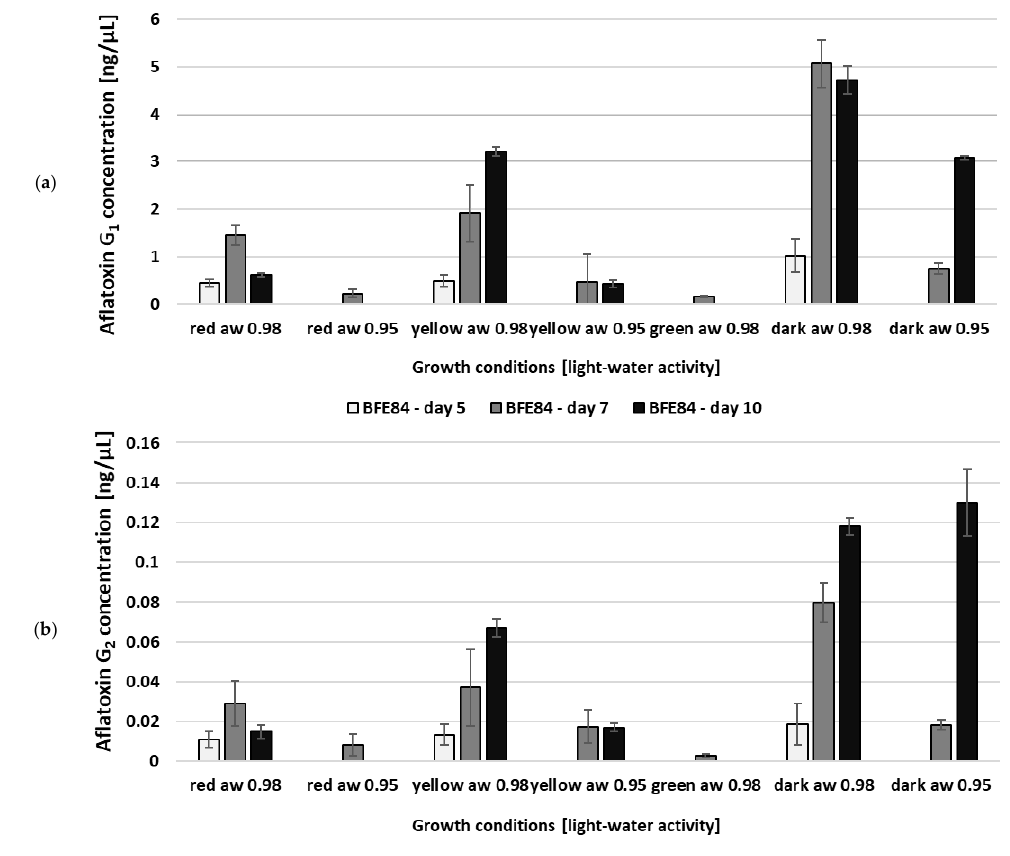
Figure 3. Aflatoxin G 1 ( a ) and G 2 ( b ) formation by Aspergillus parasiticus BFE84, dependent on different combinations of light and water activity. No aflatoxin formation was detectable under white light, a w 0.98 and a w 0.95; green light and a w 0.95; and blue / royal blue light. Standard deviations are given for each parameter. The measured values were too low for statistical significance